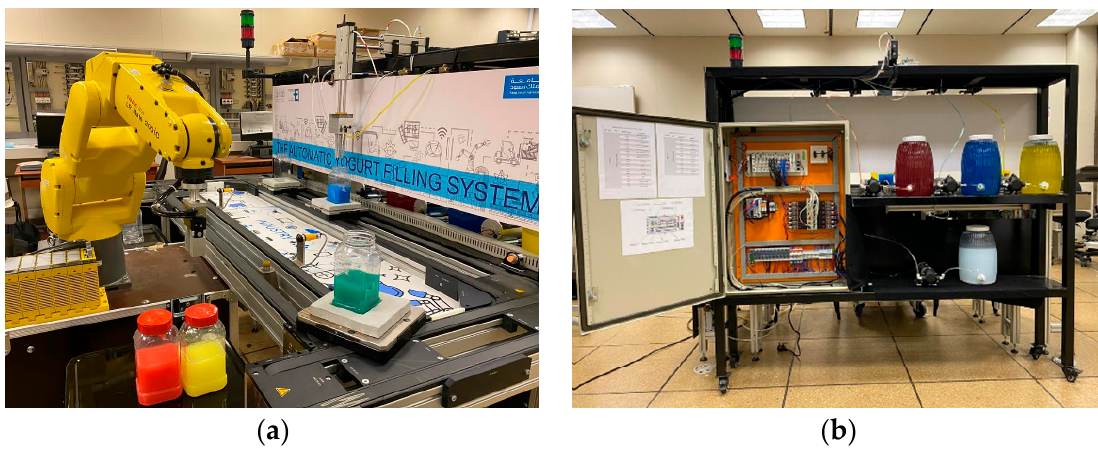
Figure 2. System architecture and integration. ( a ) Robot in action ( b ) Feedback and control system panel